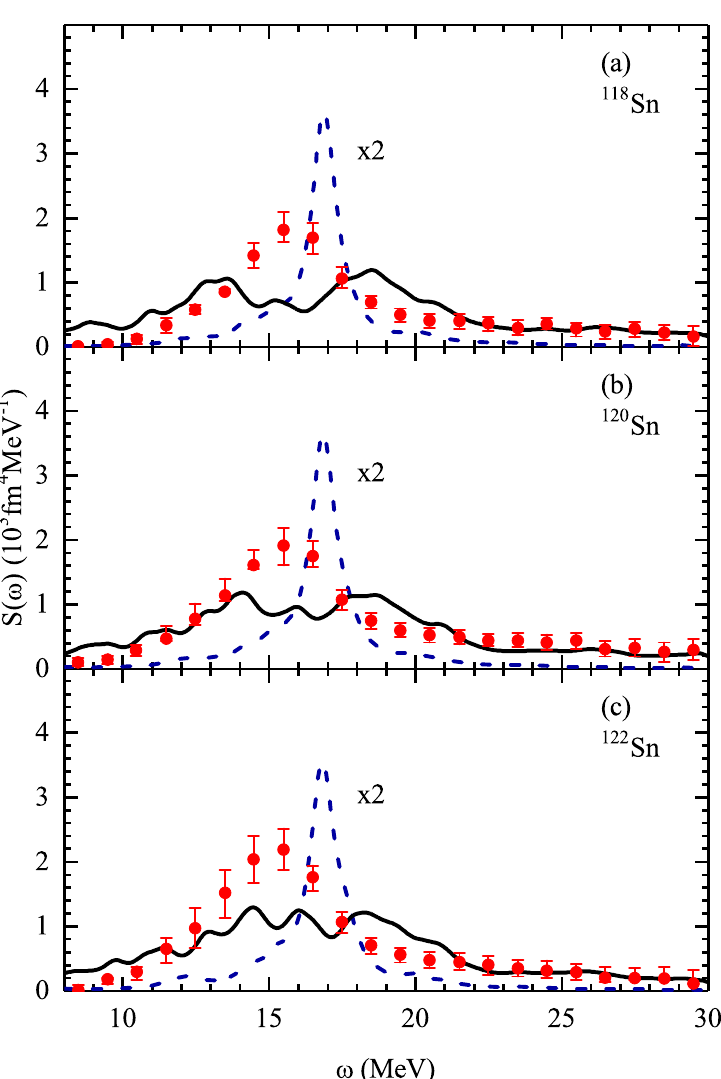
Figure 1. The calculated ISGMR strength distributions for 118 Sn (panel ( a )), 120 Sn (panel ( b )), and 122 Sn (panel ( c )) are compared with the experimental data from [10]. The QRPA results (dashed curves) are scaled down by a factor of 2 for a better display. The solid curves correspond to the results obtained by means of the coupling between the one- and two-phonon configuration. The distributions were calculated with the Skyrme force SLy4. The smoothing parameter 1 MeV was used for the strength distribution described by the Lorentzian